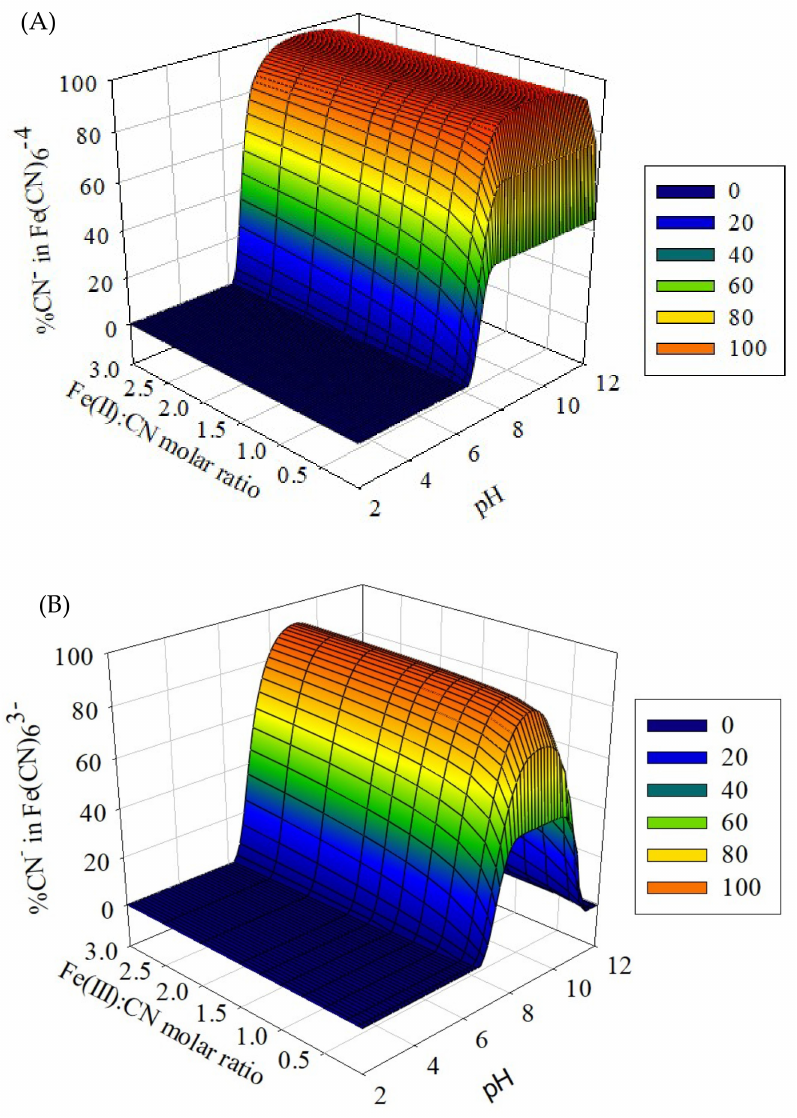
Figure 2. Percentage of ( A ) CN − in Fe II (CN) 64 − and ( B ) CN − in Fe III (CN) 63 − as a function of Fe:CN − molar ratio and pH modeled by MINEQL+. Fixed CN − concentration of 10 mg/L. Temperature of 25 ◦